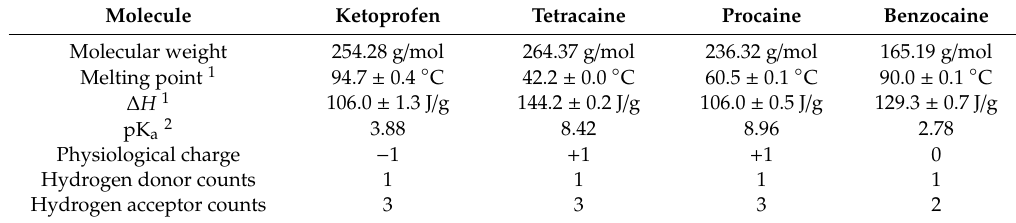
Figure 1. Chemical structures of the investigated molecules: ( a ) ketoprofen (KET), ( b ) procaine (PRO), ( c ) tetracaine (TET) and ( d ) benzocaine (BEN). Table 1. Physicochemical properties of the investigated molecules (obtained from [32]).